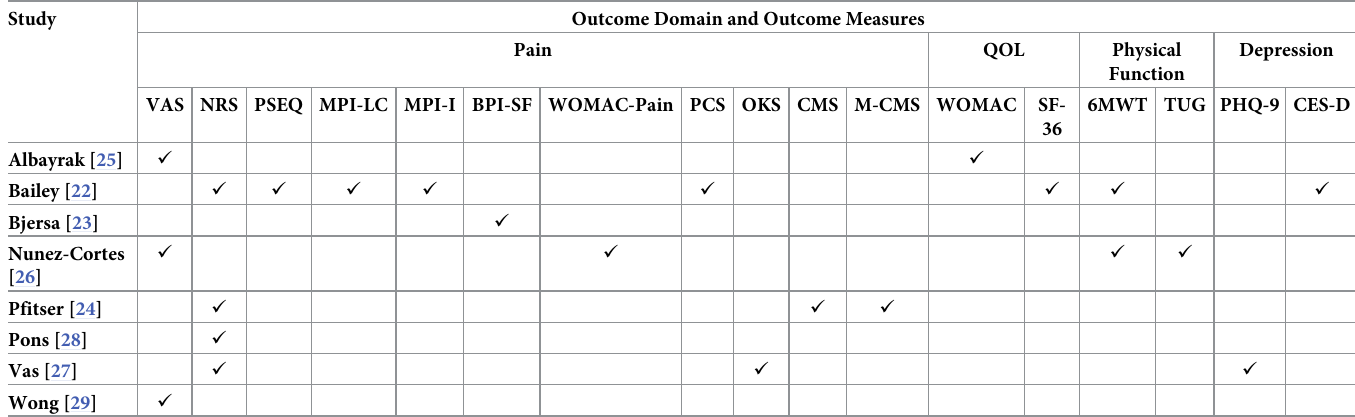
Table 3. Outcome measures.